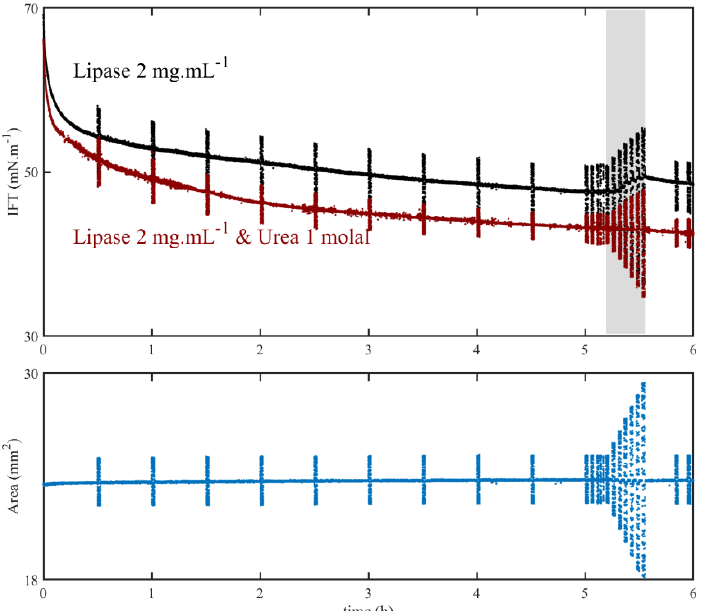
Figure 6. Effect of aging on the dynamic interfacial tension of the adsorbed layers from 2 mg ⸱ mL − 1 lipase solutions without and with 1 molal urea ( top ) and the imposed oscillations on the droplet area ( bottom ); the period of amplitude sweep is shown with a gray background.